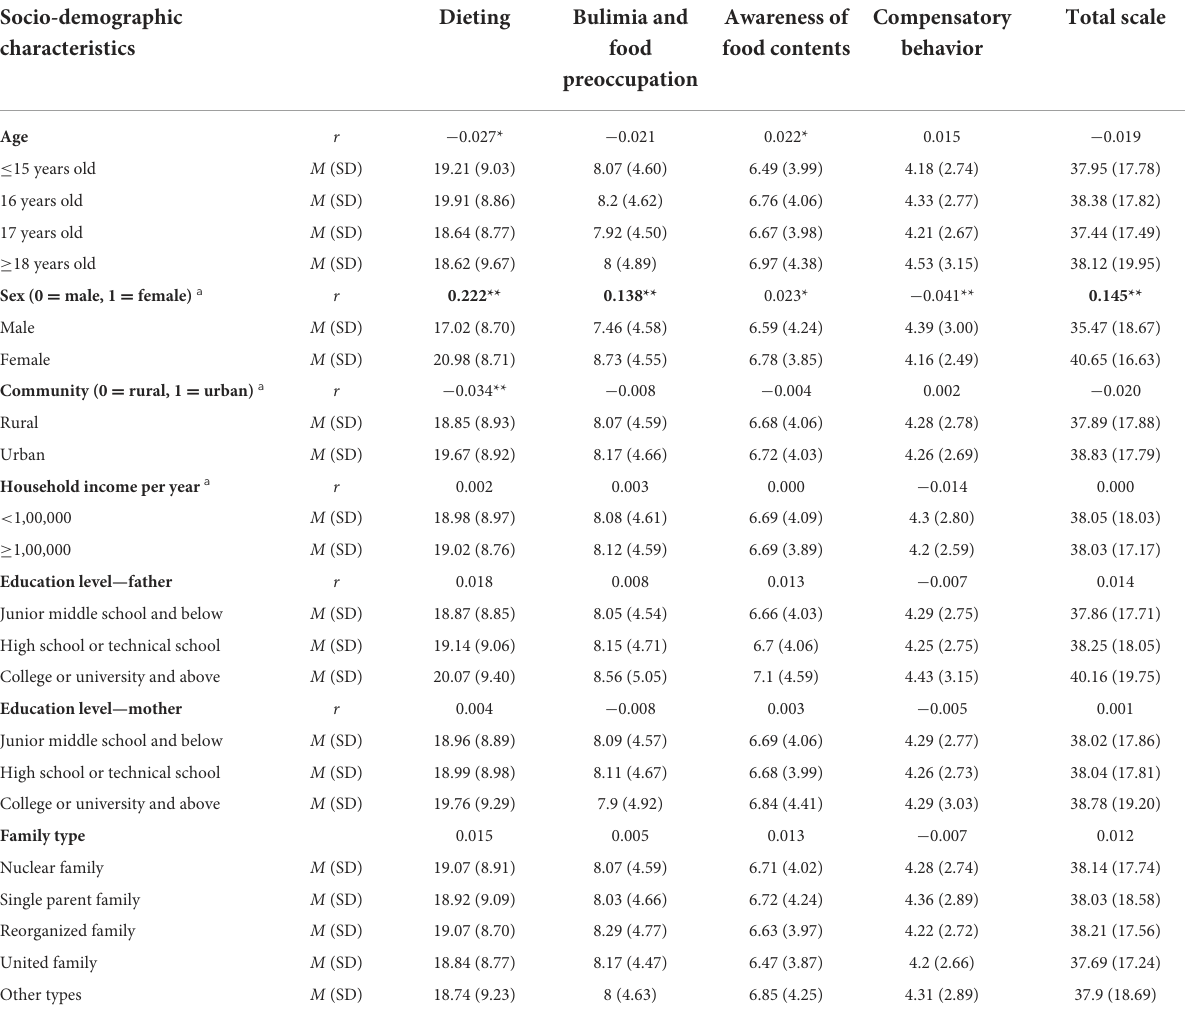
TABLE 6 Tests of associations of student socio-demographic characteristics with abnormal eating attitudes. Socio-demographic characteristics